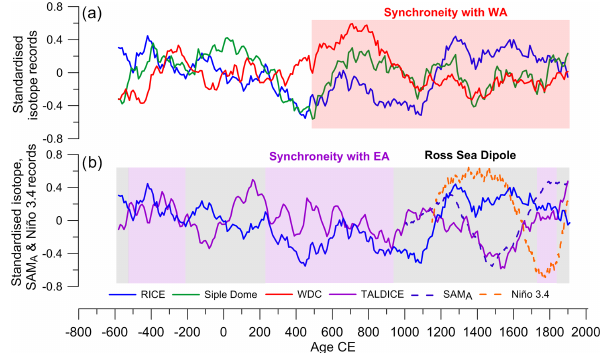
Figure 8. Phasing of multi-decadal and centennial climate temper- ature variability at RICE, Siple Dome, WDC and TALDICE using detrended, normalised isotope records, smoothed with a 200-year moving average. RICE is compared with (a) Siple Dome and WDC and (b) TALDICE to investigate phase relationships of climate vari- ability in the eastern Ross Sea (RICE, Siple Dome) with West (WDC) and East Antarctica (TALDICE). WA: West Antarctica; EA: East Antarctica. The red shading indicates periods of synchroneity of RICE and Siple Dome records with WA. Grey shading indicates time periods where RICE (eastern Ross Sea) shows an anti-phase re- lationship (a Ross Sea Dipole) with TALDICE (western Ross Sea). Purple shading identifies times when RICE and EA are in phase. The normalised SAM A and Niño 3.4 records, smoothed with a 200- year moving average, are shown for comparison.